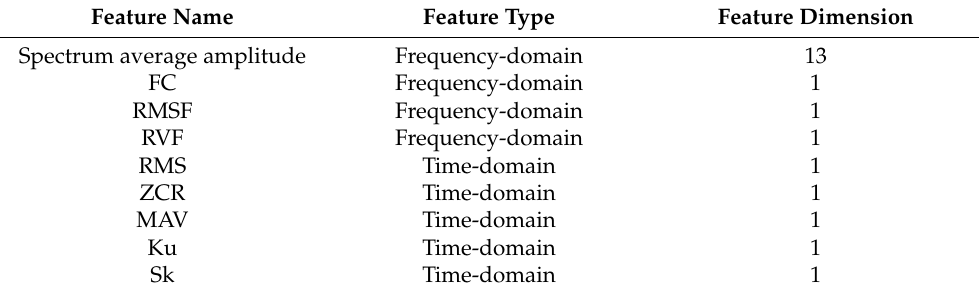
Table 2. Name, type, and the dimension of each